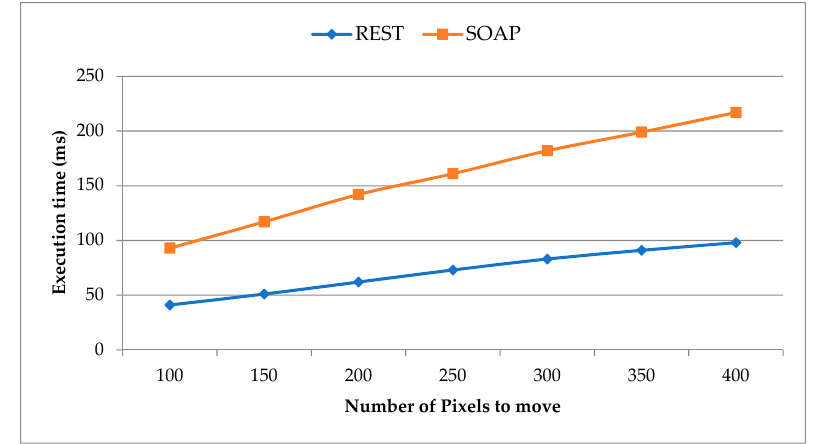
Figure 17. Map navigation query based on pixels move request Table 2. SOAP web services vs. REST web services.